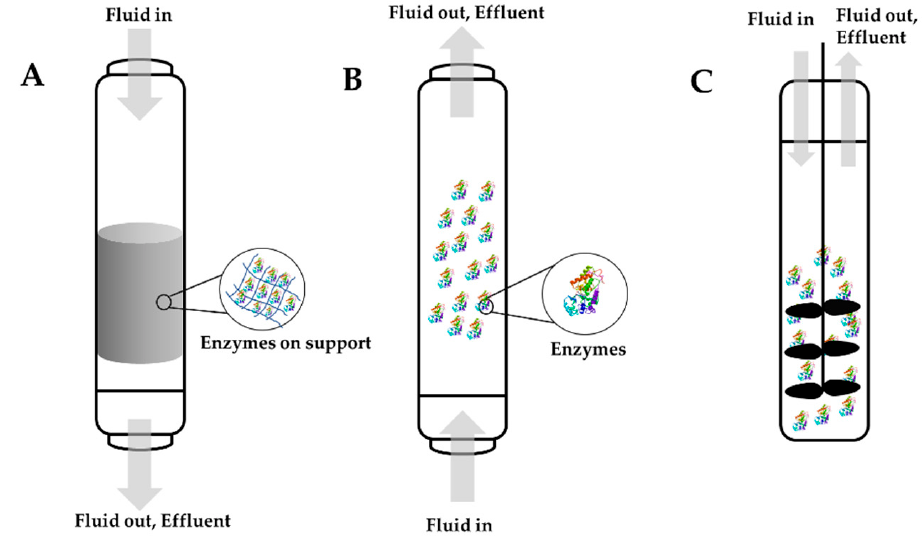
Figure 7. Some of the commonly used types of bioreactors: ( A ) fixed bed bioreactors, ( B ) fluidized bed bioreactors, and ( C ) stirred tank bioreactors.